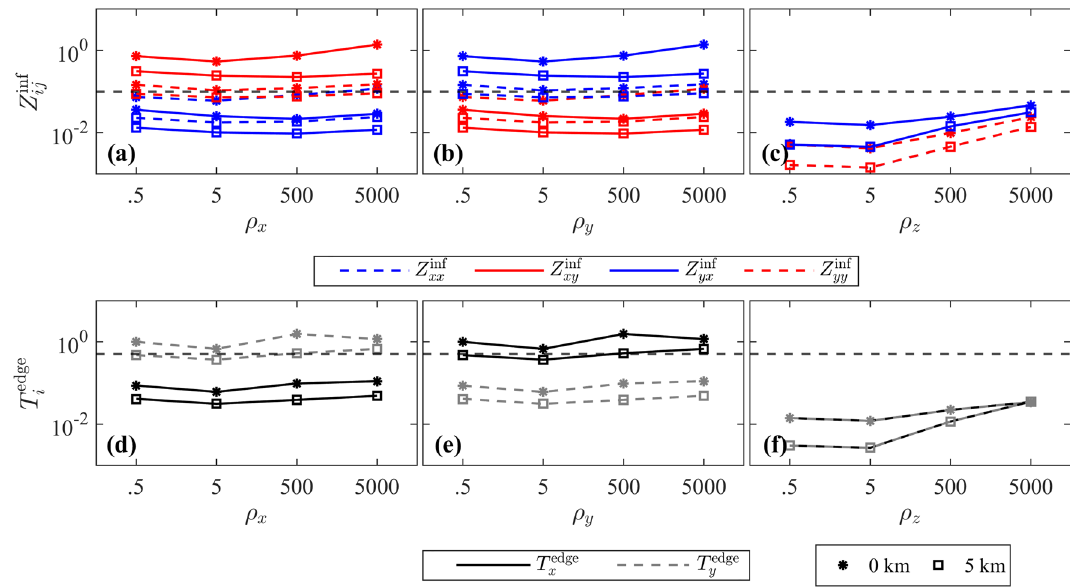
Fig. 4 (top) Logarithmic plots of the overall impedance tensor influence index Z inf xx , Z inf yy , Z inf xy , and Z inf yx when varying a ρ x , b ρ y , and c ρ z , respectively. (bottom) Logarithmic plots of the overall tipper edge effect indices T edge x , and T edge y when varying d ρ x , e ρ y , and f ρ z , respectively. The varying resistivity values are shown on the x ‑axis. The dashed lines mark 10% for Z inf ij and 50% for T edge i for reference. The asterisk and square are for the cases where the buried depth of the 3‑D body is 0 km and 5 km,